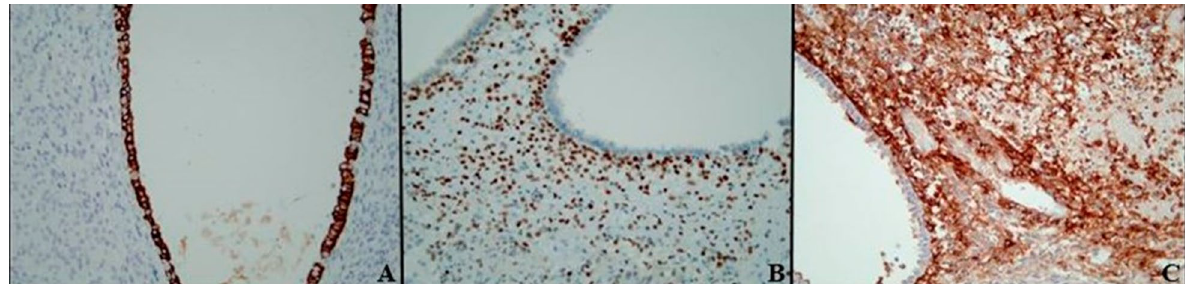
Fig. 3 AMLEC (IHC: Immunohistochemistry). A CK7 positive in the epithelial cells lining the cystic spaces X200. B ER nuclear positivity in the subepithelial stromaX200. C CD10 staining the subepithelial stroma